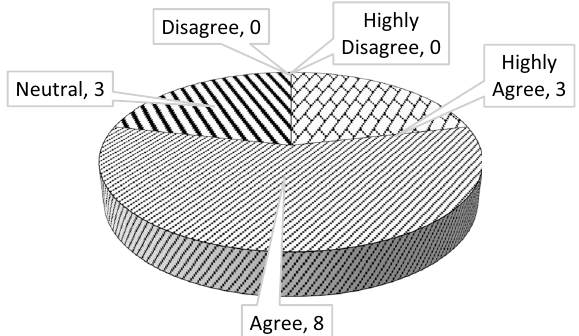
Fig. 9 Survey response of market factors by Pakistani ICT professionals